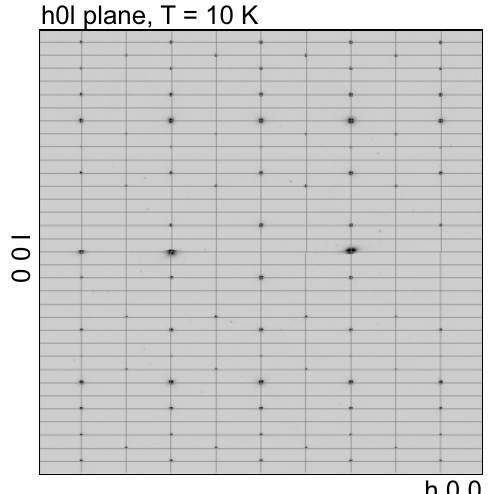
Figure 1: Reconstructed reciprocal space plane (h 0 l) at 10 K. The reciprocal lattice grid extracted from the calculated unit cell provides a correct indexing of the mea- sured Bragg peaks.